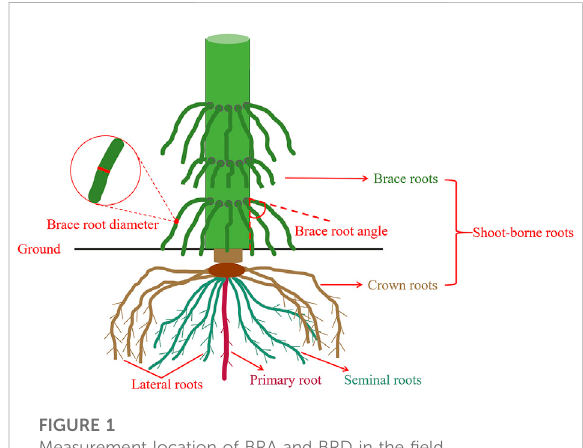
FIGURE 1 Measurement location of BRA and BRD in the fi eld.